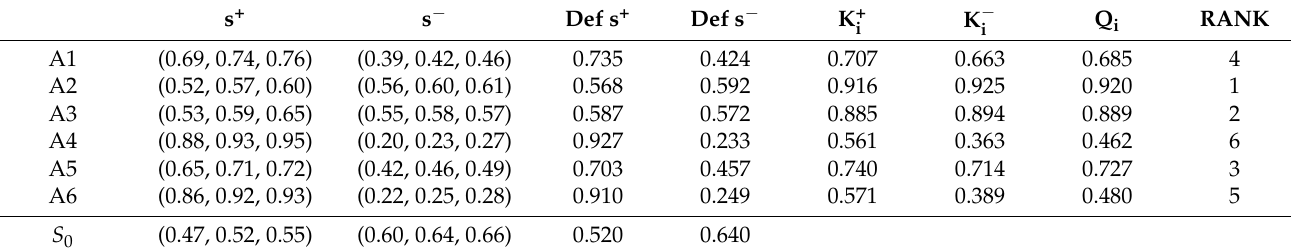
Table 9. Deviation of alternatives from ideal solutions and final ranking